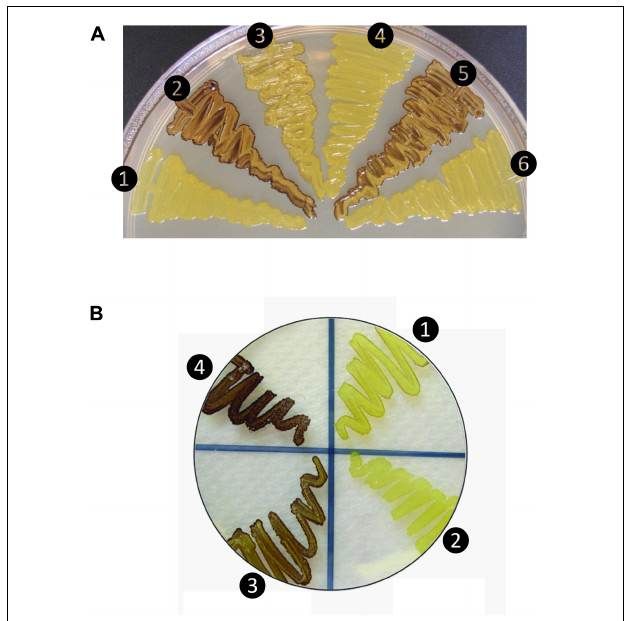
FIGURE 1 | Glycogen production profiles of AGPase variants. (A) Rice AGPase S2b subunit were co-expressed in Escherichia coli EA345 ( (cid:49) glgC ) with: 1, no LS; 2, rice AGPase L2 (L2); 3, potato tuber LS (pLS); 4, pLS:L2; 5, L2:pLS; and 6, L2:pLS K471N . K471N: lysine-471 was substituted with arginine on the β -helix domain of potato LS. Overnight grown cells were exposed to iodine vapor for glycogen staining. Exposure time: 2 min. (B) Rice AGPase L2 subunit were co-expressed with: 1, S2b; 2, green fluorescent protein (GFP, negative control); 3, S2b QTC mutant. 4: wild type potato tuber AGPase used as positive control. Exposure time: 30 s. Note the exposure time to iodine vapor was adjusted to emphasize the difference in glycogen production between the potato pLS/pSS and rice